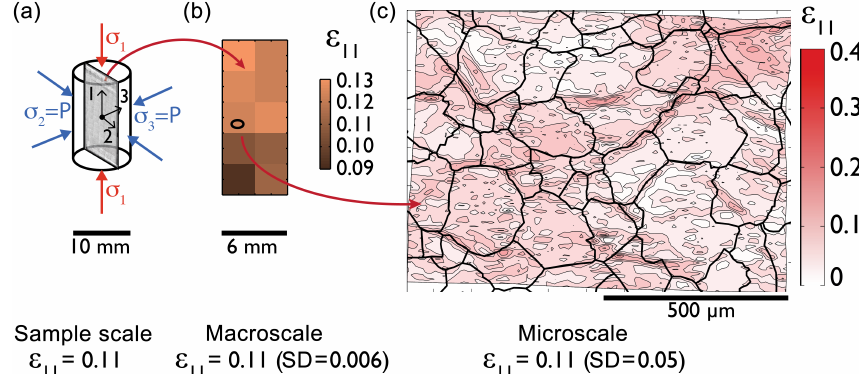
Figure 9. Strain maps over different regions of interest for a Carrara marble split cylinder deformed at T = 600 ◦ C and P c = 300MPa to 11% shortening strain at 3 × 10 − 5 s − 1 (a) . The component along the shortening direction of the strain tensor, ε 11 , was computed at different scales. In panel (b) , ε 11 was computed over the whole sample with a gauge length of 3mm (macroscale). In panel (c) , ε 11 was computed over a smaller region of interest with a 20µm gauge length (microscale) and is mapped with the overlaying grain boundaries. Positive strains correspond to shortening. Modified after Quintanilla-Terminel and Evans (2016).